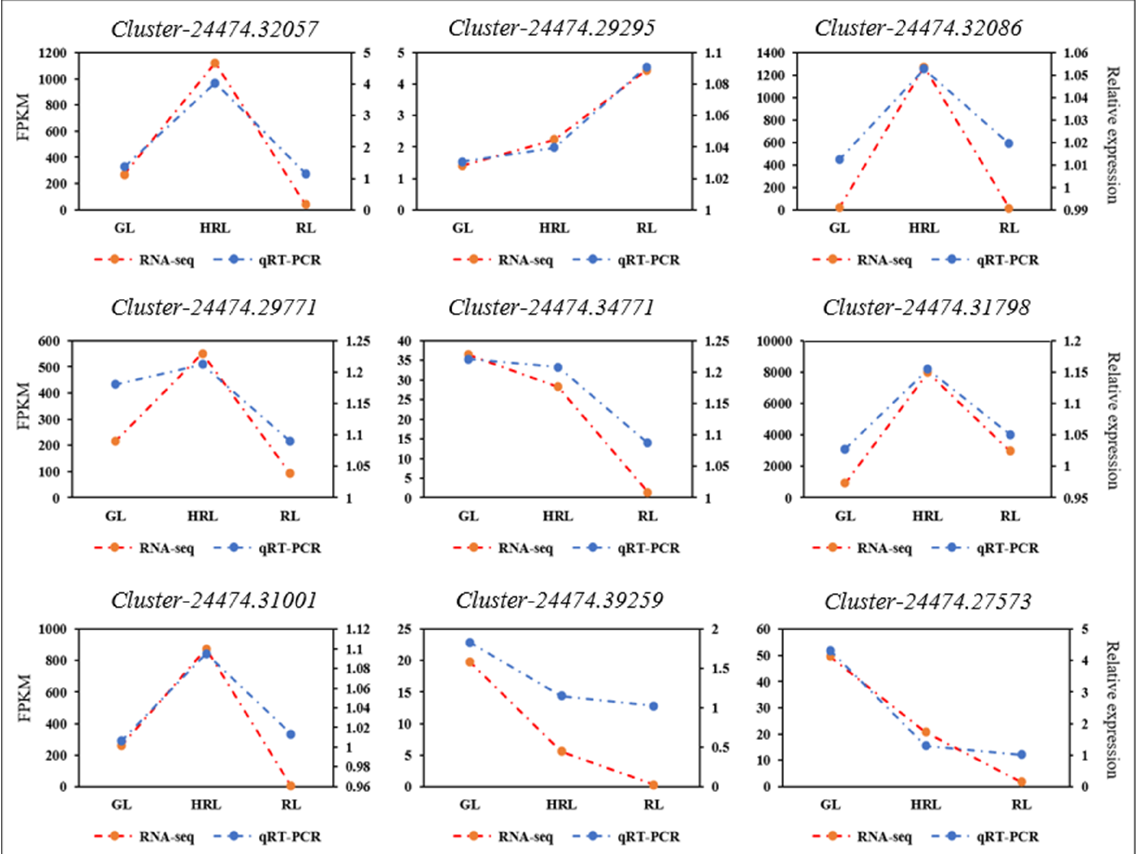
Figure 11. Expression patterns of anthocyanidin-biosynthesis-related differentially expressed genes (DEGs) in green (GL), orange (HRL), and red (RL) leaves by qRT ‐ PCR.